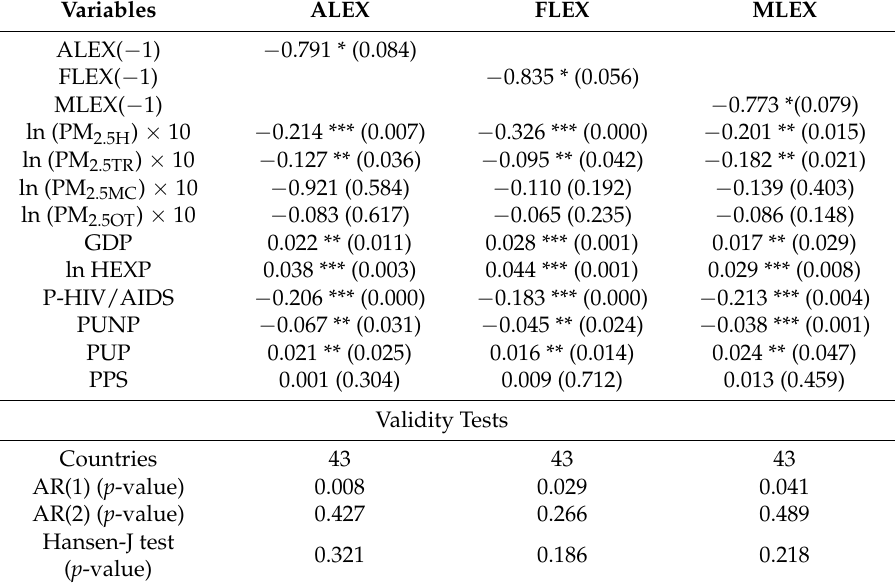
Table 1. Estimated regression coefficients for the effect of particulate matter with diameter smaller than 2.5 µ m (PM 2.5 ) from household combustion and other variables on the three (3) life expectancy variables. Variables ALEX FLEX MLEX ALEX( −